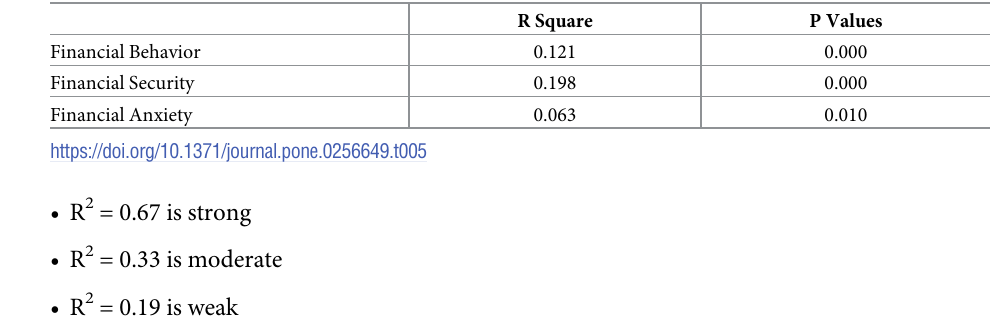
Table 5. Coefficient of determination (R2) of model.